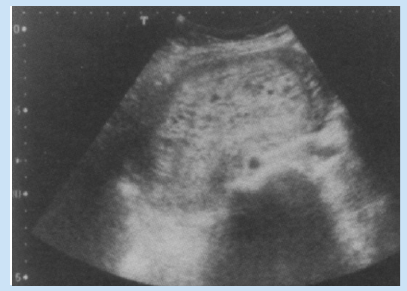
Fig. 1a. Transabsominal transverse scan showing a vesicular echogenic mass filling the endometrial cavity.